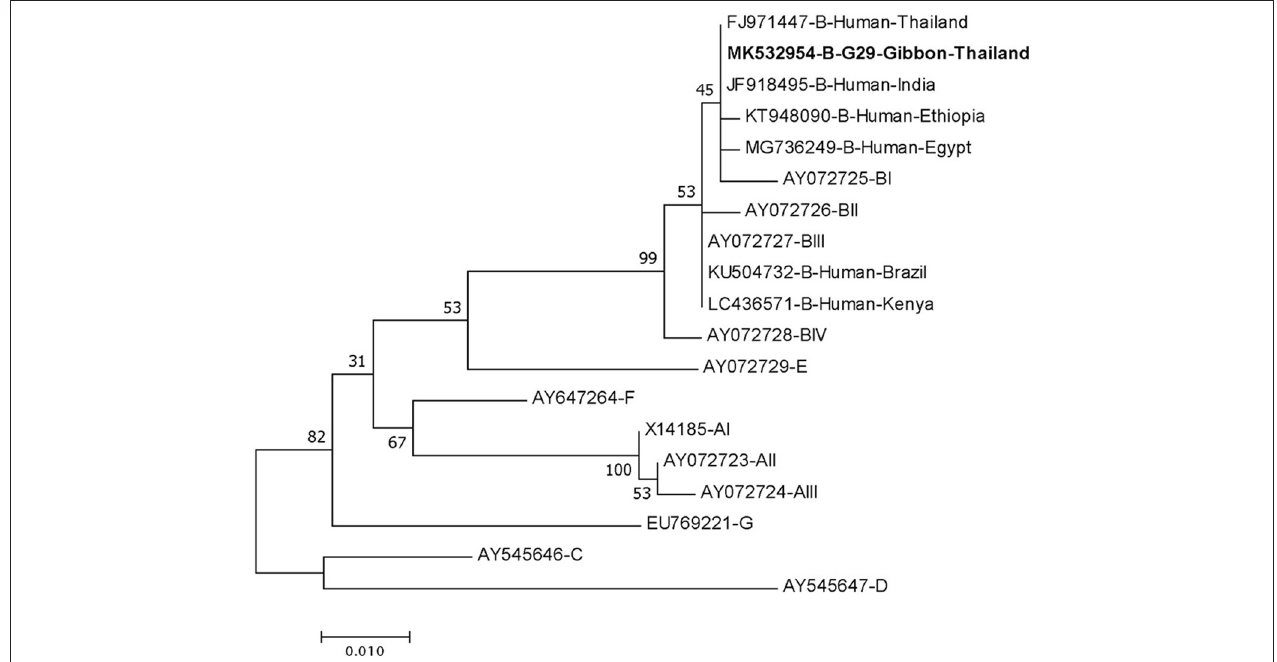
FIGURE 3 | Phylogenetic tree of Giardia isolate based on the sequence of beta-giardin (bg) gene from a gibbon in this study by the Maximum Likelihood algorithm using the MEGA 6.06 program. Sequences obtained from GenBank are indicated by their accession numbers. Percentage bootstrap supports (500 replicates) are shown by numbers at the respective nodes. Bold texts represent the Giardia detected in this